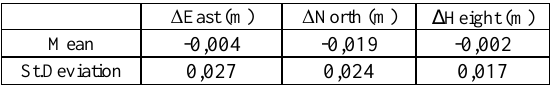
Table 5. Average coordinates differences between points from TLS and photogrammetric models and their standard deviations.